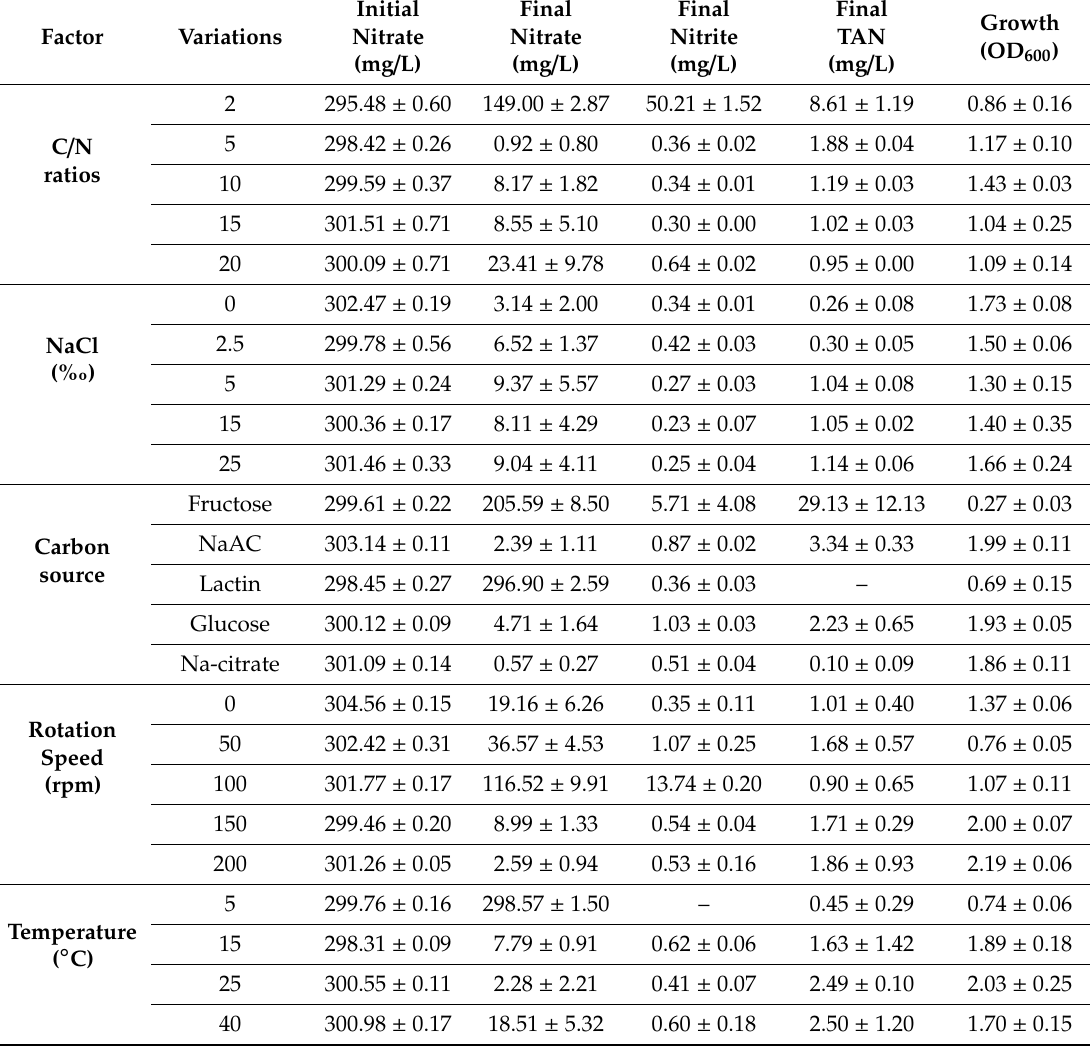
Table 4. Varied single factors on the aerobic denitrification performance of strain RAD-17 after 48 h